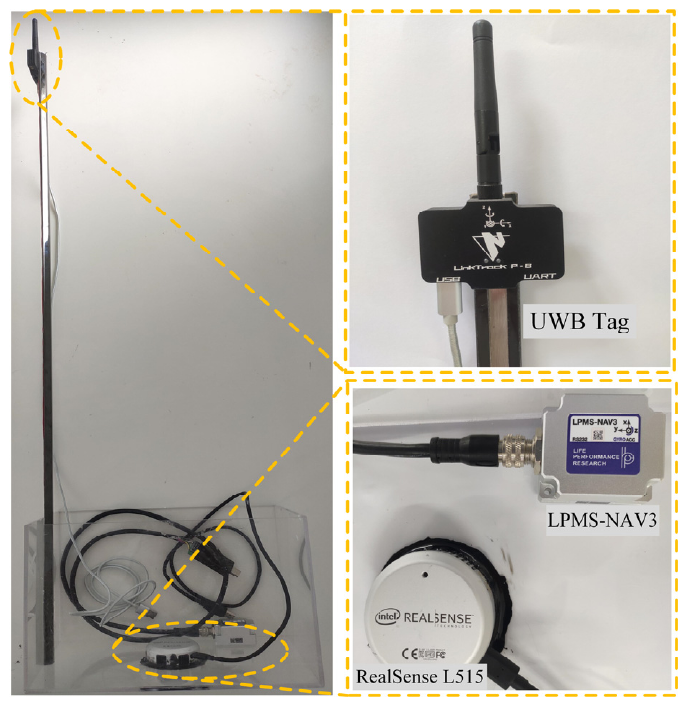
Figure 1. The Layout of Sensors.